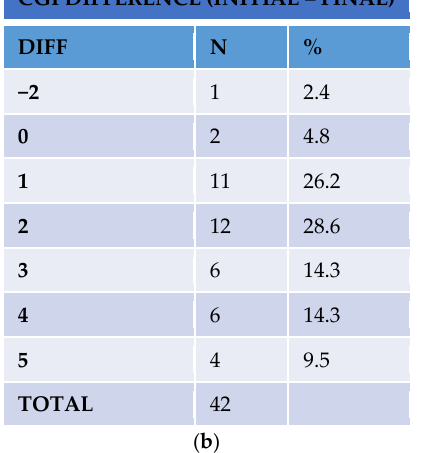
Figure 1. CGI results after pharmacogenetic intervention: ( a ) final CGI scores; ( b ) CGI score difference (CGI basal–final).